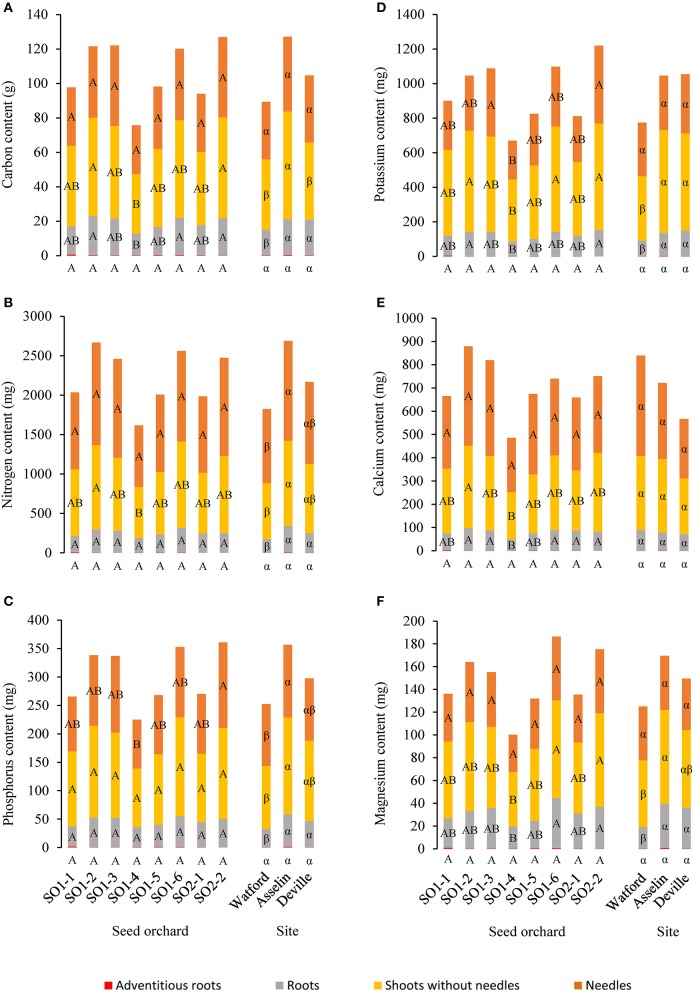
Average distribution of nutrient content between seedling parts (adventitious roots, roots, shoots without needles and needles) as a function of seed orchard and planting site (n = 96) for (A) carbon, (B) nitrogen, (C) phosphorus, (D) potassium, (E) calcium, and (F) magnesium contents. For the same seedling part, means with the same letter within seed orchard or site are not significantly different according to a Tukey test at α = 0.05. The content was based on dry mass.